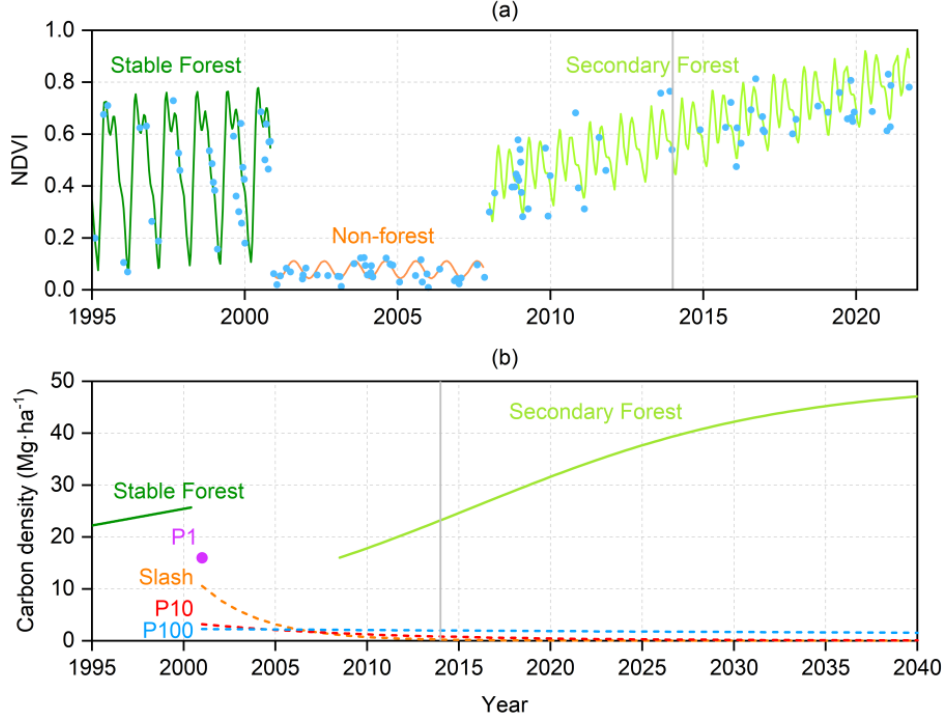
Figure 3. Panel ( a ) shows Landsat time series of NDVI and change segments identified by the CCDC model for a pixel. Panel ( b ) shows the carbon density trends of different carbon pools associated with the land cover dynamics of this pixel. NDVI and carbon density profiles for forest clearance or regrowth in a pixel suggested consistent trends. In particular, the carbon uptake effect of forest regrowth and the carbon emission effect of forest loss are obvious.